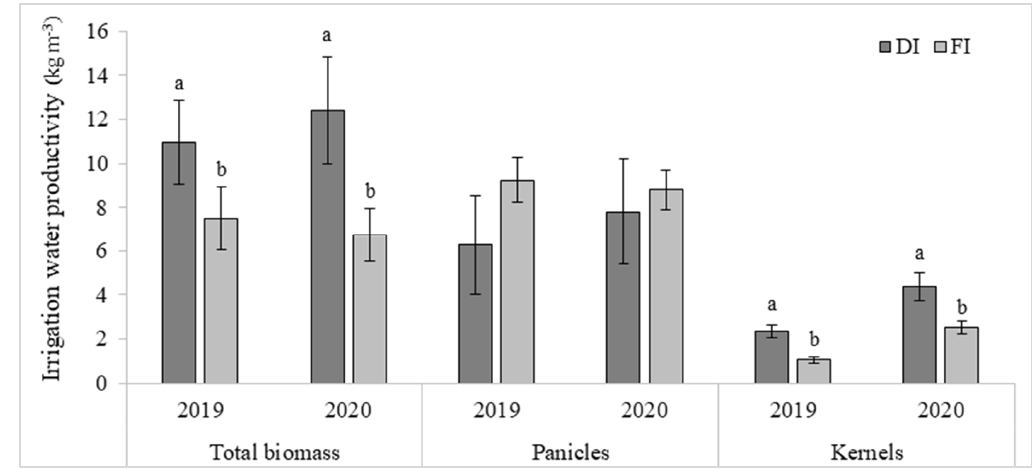
Figure 5. Irrigation water productivity (kg m − 3 ). Vertical bars indicate standard deviation (SD). Data with different letters indicate significant differences at ( p ≤ 0.05).